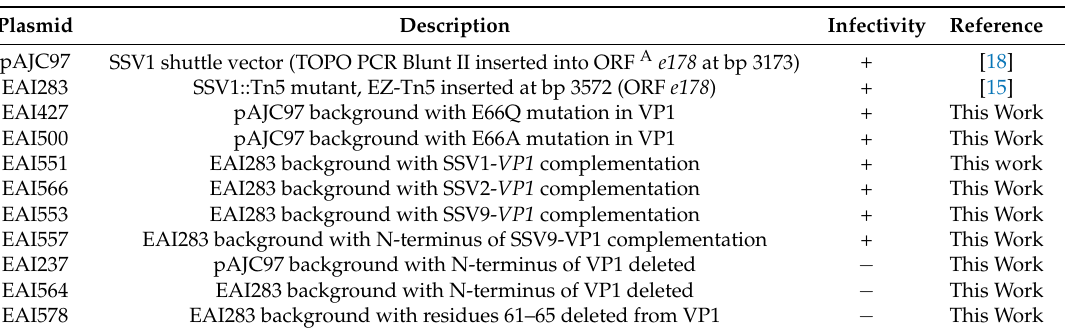
Table 1. Plasmids used in this